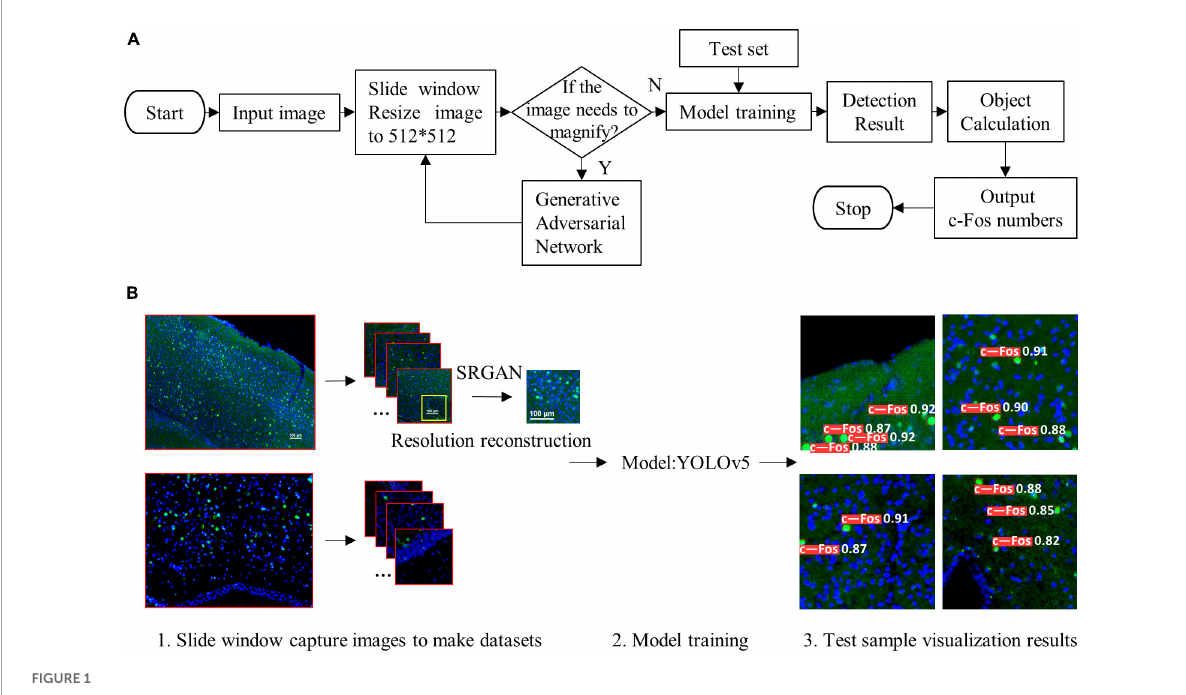
FIGURE1 Pipeline of the proposed algorithm. (A) Simple flow chart. (B) Flow chart of visualization. The proposed system (1) used sliding window and resized the input images to 512 × 512, (2) reconstructed resolution of images, (3) trained detection model, and (4) outputted visualization results.